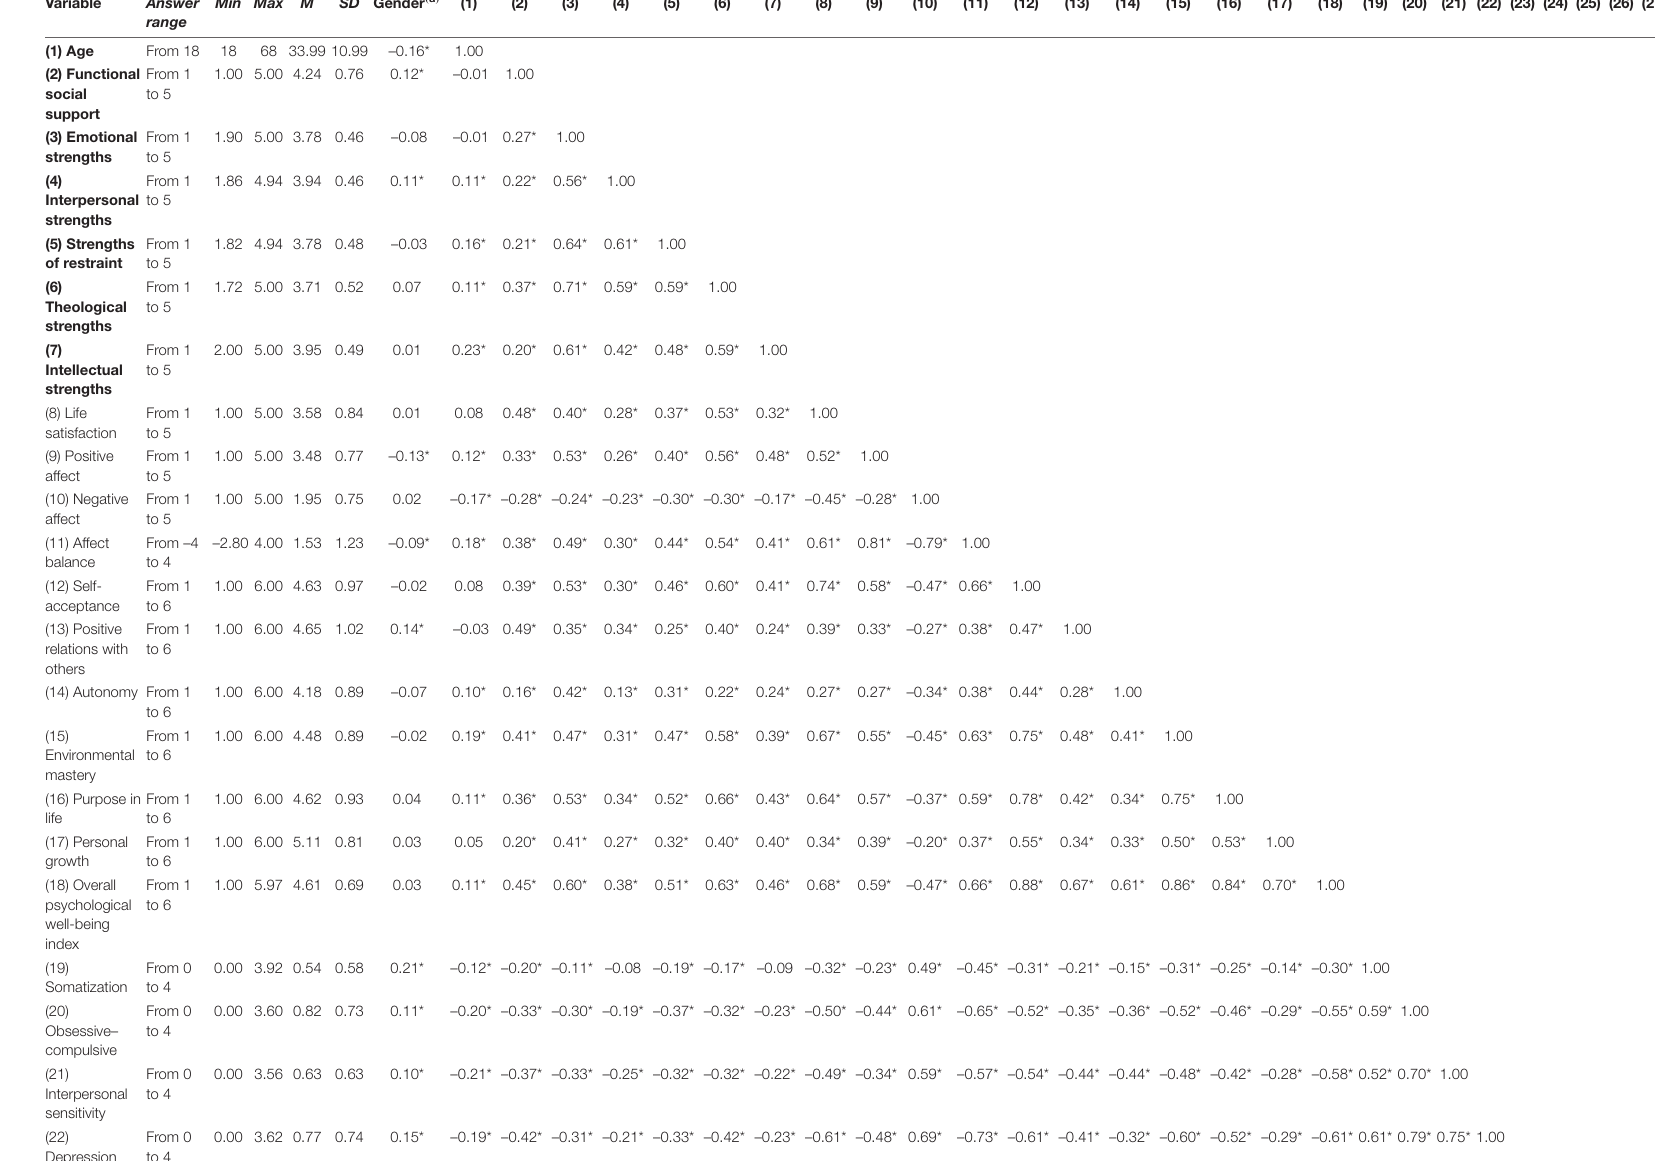
TABLE 3 | Descriptive statistics, answer ranges and partial correlations (adjusting the effect of gender and age) between the variables ( N = 1494).